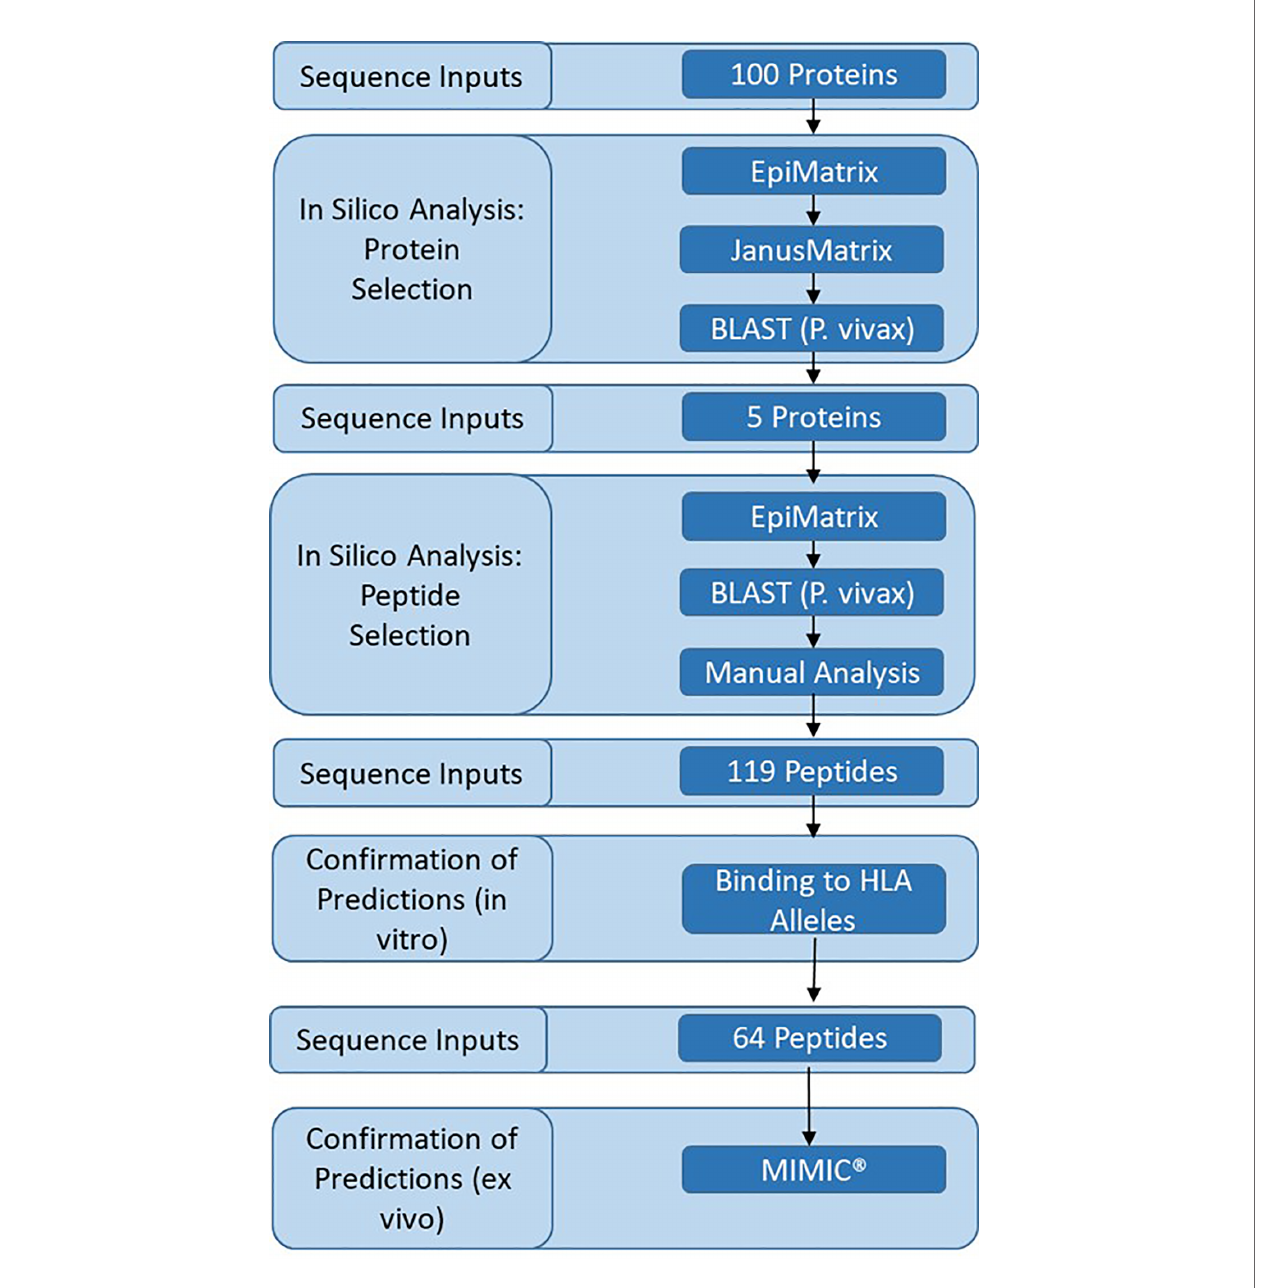
FIGURE 1 | Experimental framework and analysis work fl